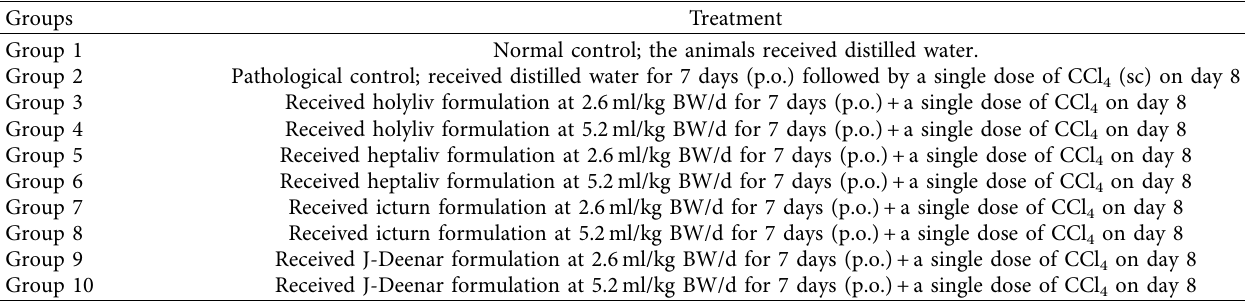
Table 2: Dosage of orally administered drug in various groups in carbon tetrachloride-induced toxicity. Groups Treatment Group 1 Normal control; the animals received distilled water.